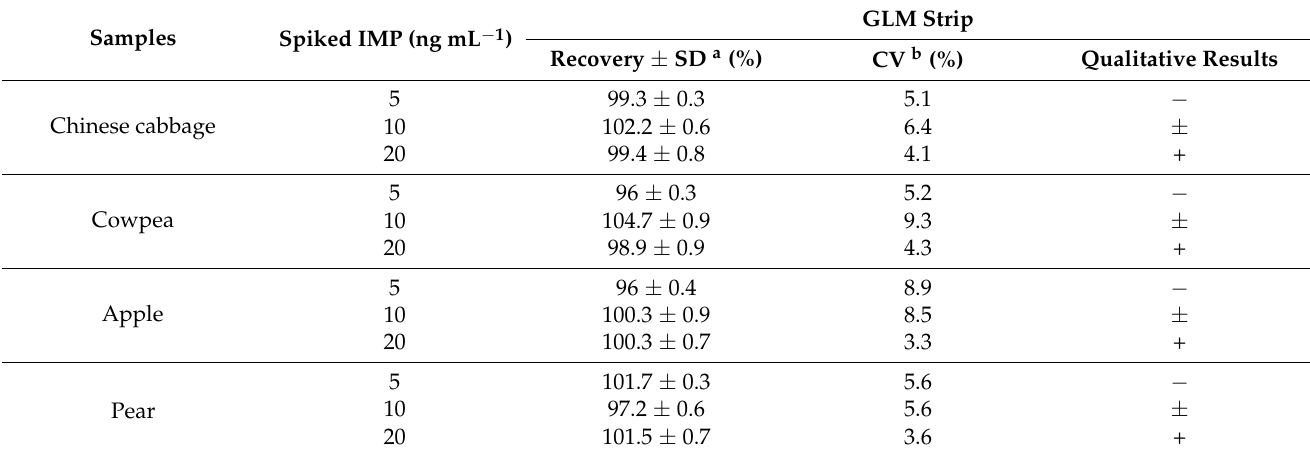
Table 2. Results of IMP detection in Chinese cabbage, cowpea, apple, and pear samples using LFA ( n =